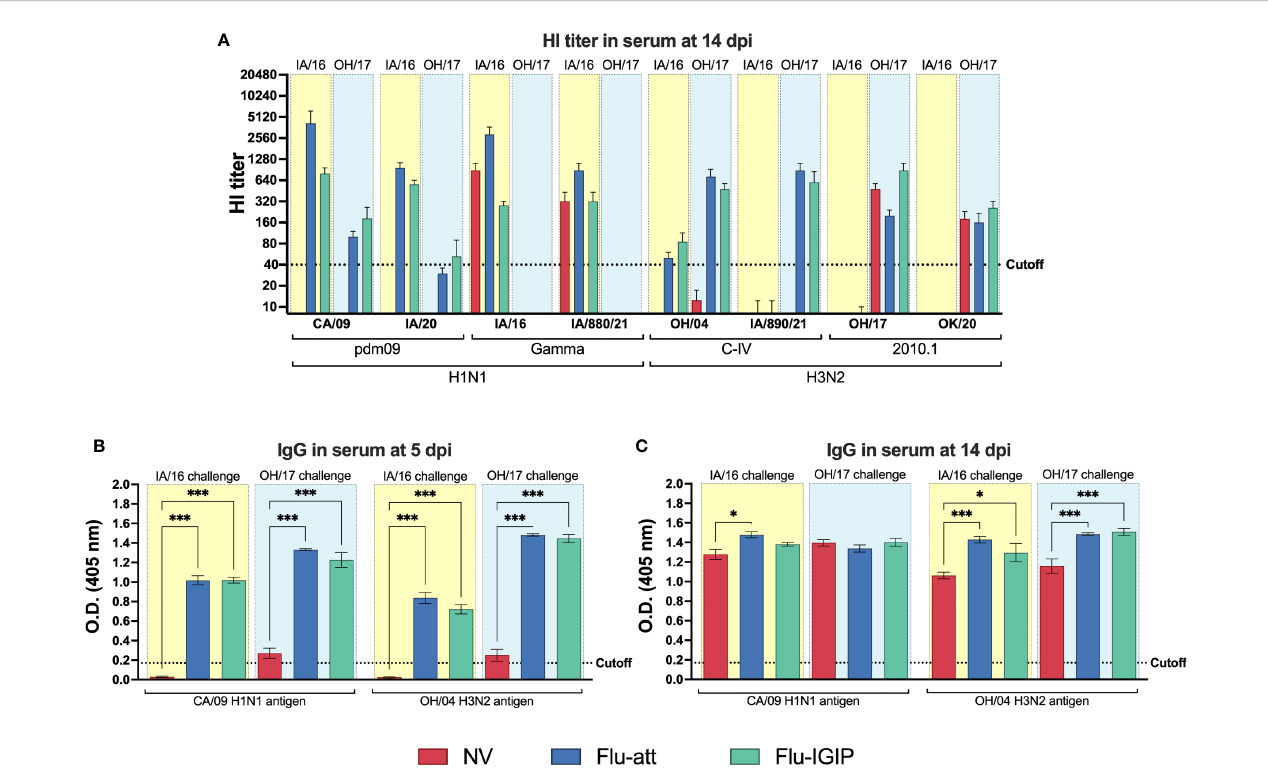
FIGURE 2 In fl uenza-speci fi c antibody response in serum after inoculation. Pigs were not vaccinated (NV, red bars) or vaccinated with bivalent Flu- att (blue bars) or Flu-IGIP (green bars) containing CA/09 H1N1 and OH/04 H3N2 viruses. Pigs were challenged with IA/16 H1N1 (light-yellow boxes) or OH/17 H3N2 (light- blue boxes) viruses. Hemagglutination inhibition titers were measured (A) 14 days post inoculation (dpi). IgG levels were measured in serum by ELISA at (B) 5 and (C) 14 dpi. Viruses on the x-axis represent antigens used in each assay: CA/09, A/California/04/09 (H1N1pdm09); IA/20, A/swine/Iowa/ A02524480/2020 (1A.3.3.2 H1N1pdm09); IA/16, A/swine/Iowa/A01778877/2016 (1A.3.3.3 gamma H1N1); IA/880/21, A/swine/Iowa/A02245880/2021 (1A.3.3.3 gamma H1N1); OH/04, A/turkey/Ohio/313053/2004 (H3N2 C-IV); IA/890/21, A/swine/Iowa/A02635890/2021 (H3N2 C-IVA); OH/17, A/swine/ Ohio/A01354299/2017 (H3N2 2010.1); and OK/20, A/swine/Oklahoma/A02479048/2020 (2010.1 H3N2). Results displayed as means ± standard error of the mean. Vaccine and challenge viruses and additional antigenically distinct viruses were used as HI antigens and vaccine viruses as ELISA antigens. Results displayed as means ± standard error of the mean. Dotted lines indicate assay cutoff values known to be protective for HI assays or calculated as the average of negative pigs + 3 times the standard error of the mean for ELISA assays. *p ≤ 0.05; ***p ≤ 0.001 within groups challenged with the same